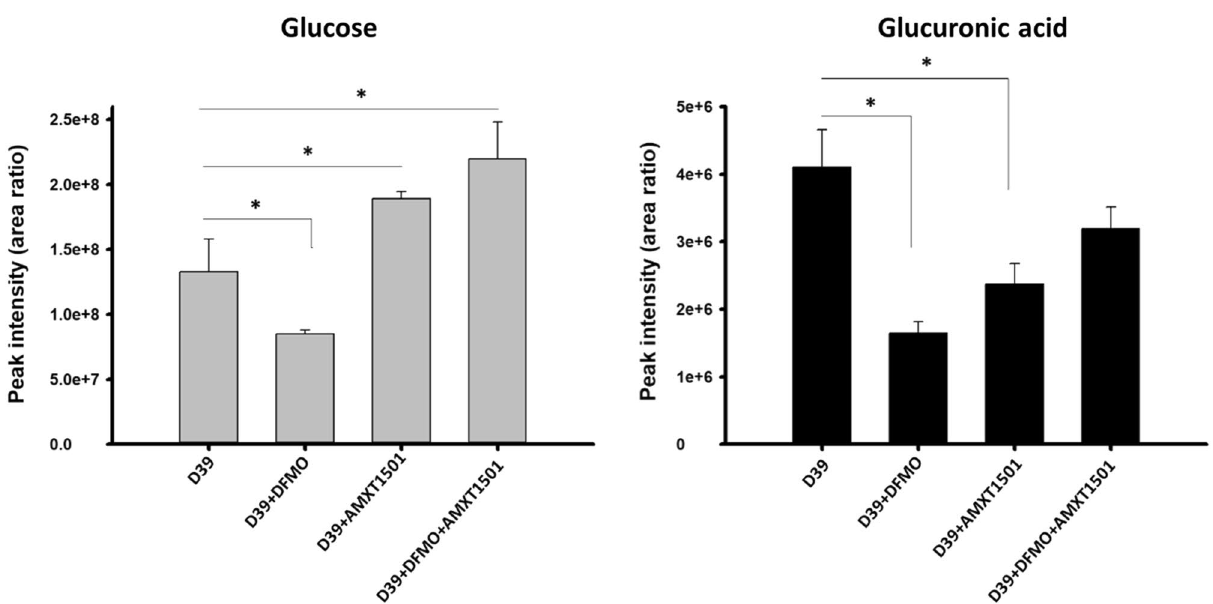
Figure 7. DFMO and AMXT 1501 impact intracellular concentrations of glucose and glucuronic acid in pneumococcal D39. Serotype 2, D39, was treated separately with 1/8 MIC DFMO (34 mM), 1/2 MIC AMXT 1501 (7.4 µM), and in combination, and peak intensities of glucose and glucuronic acid as a measure of their intracellular concentrations were determined. Glucose was significantly reduced in DFMO-treated cells while the presence of AMXT 1501 increases glucose level. Glucuronic acids were significantly depleted in D39 treated separately with DFMO and AMXT 1501 and were moderately reduced when in